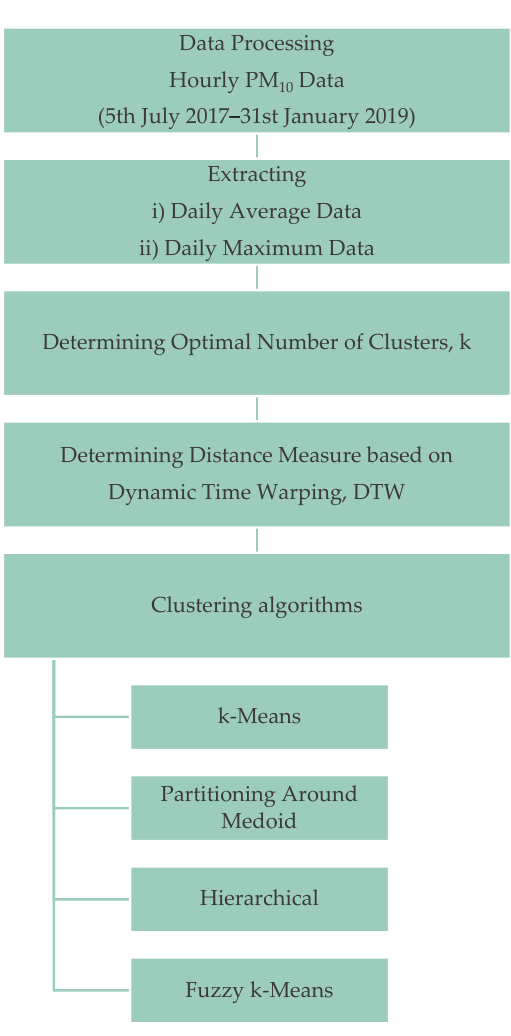
Figure 2. Maximum length of gaps of missing values for PM 10 data from 60 air quality monitoring stations in Malaysia.